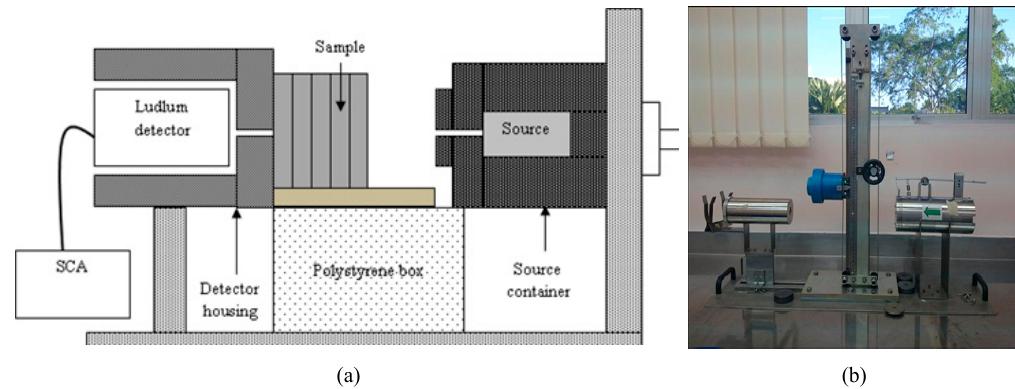
Figure 1. Ludlum setup: ( a ) schematic diagram and ( b ) actual experimental setup. The linear attenuation coefficient (LAC) and mass attenuation coefficient (MAC) are the fundamental parameters to evaluate the dosimetric and radiation shielding performance of any composite material. These commonly used parameters provide some information on the possibility of photon interaction processes with matter per unit thickness. As a photon beam propagates through a homogeneous medium, the beam intensity at depth 𝑡 is assigned as 𝐼 (cid:3047) , whereas the beam intensity at a reference point in the absorbing material ( 𝑡 = 0 ), is assigned as 𝐼 (cid:3042) . This can be described by the familiar Beer-Lambert’s law (Equation (3)) [6,7].